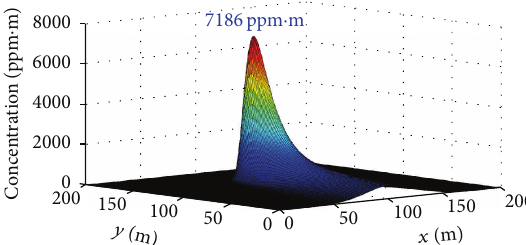
Figure5:DistributionofSO 2 concentrationofthesimulatedplume, with an outflow rate of 222 g / s and a wind speed of 2 m / s.